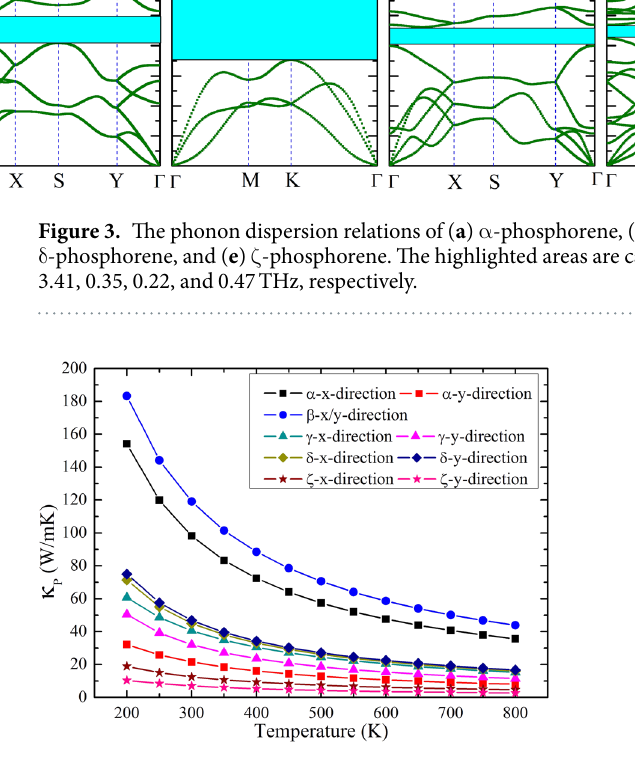
Figure 4. Calculated thermal conductivity of five phosphorene allotropes as a function of temperature.